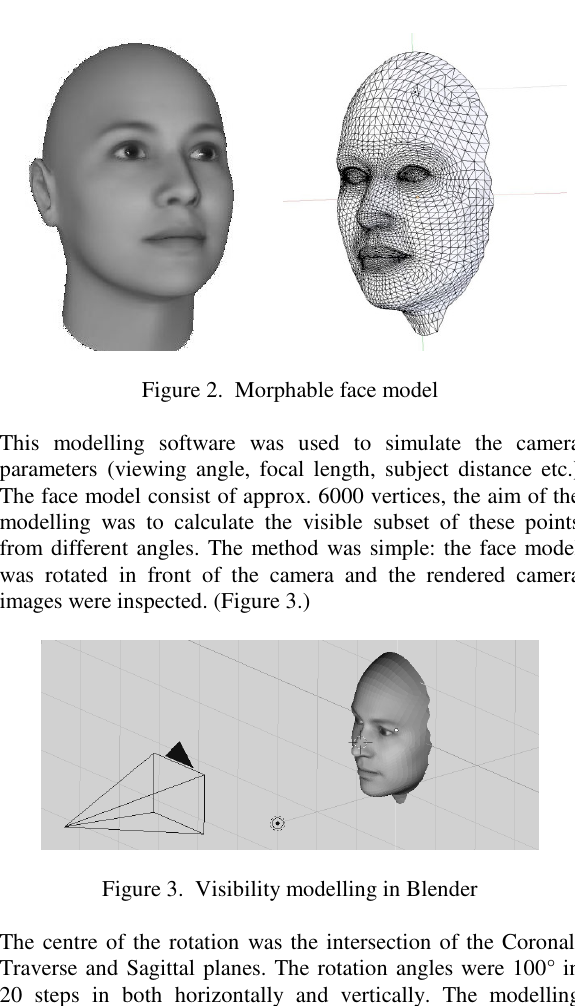
process resulted a visibility isoline map, showing the number of visible vertices from a particular camera position. (Figure 4.) The contour lines show the number of visible vertices, the axes show the camera direction from the frontal position in